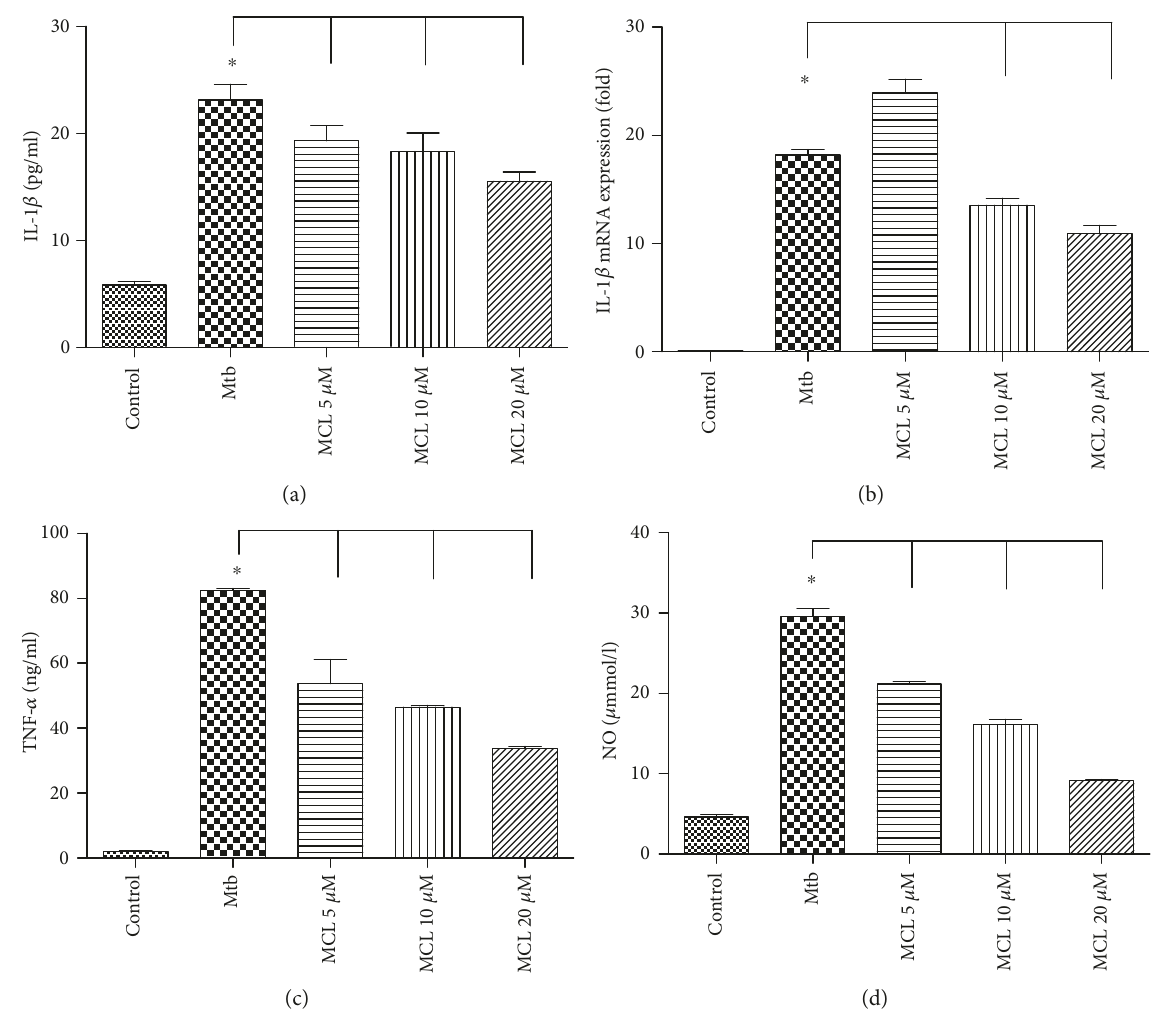
Figure 1: MCL inhibits Mtb-induced proin fl ammatory cytokine secretion. Raw264.7 cells (1 × 10 6 /well) were seeded in 6-well plates overnight and infected with H37Ra at a MOI of 10. Four hours after the infection, cells were washed with sterile PBS and then were treated with di ff erent concentrations of MCL (5, 10, and 20 μ M) for 12 hr. The concentrations of IL-1 β (a) or TNF- α (c) in the supernatants were measured by ELISA, and mRNA expression of IL-1 β (b) was detected by qRT-PCR. The concentration of NO (d) in the supernatants was measured with Nitric Oxide Assay Kit. Data are shown as the means ± SD ( n ≧ 3 ). ∗ p < 0 05